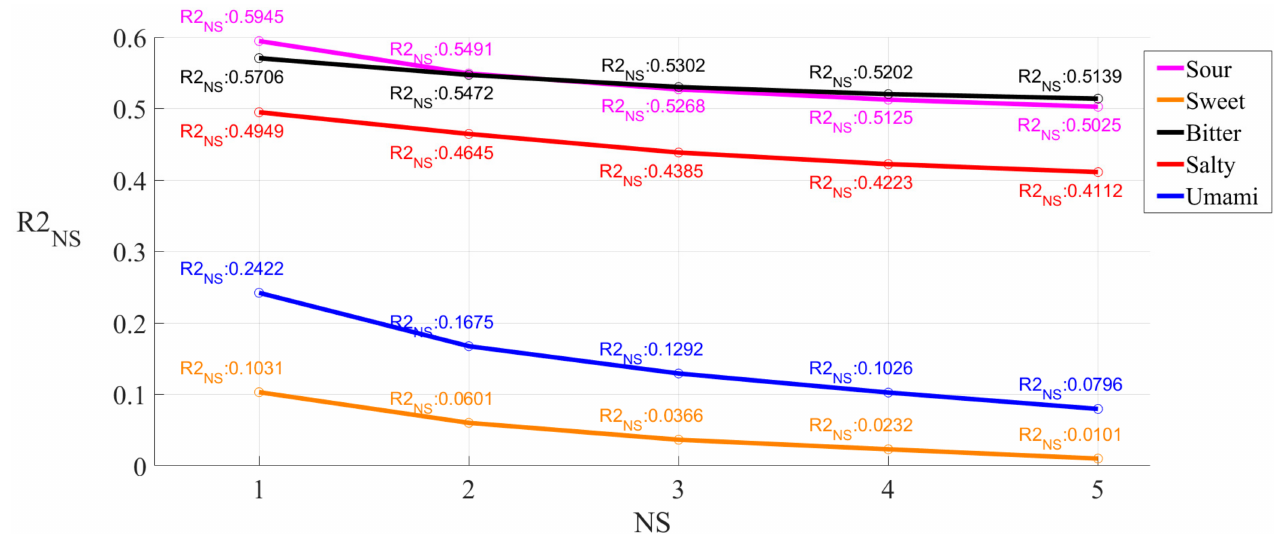
Figure 10. Relation between R 2 NS and NS. NS is the number of subjects. We listed all possible subject combinations of NS subjects for each NS (NS = 1, 2, . . . 5) and constructed a new dataset series for each combination by combining datasets series of subjects in the combination. After performing the SVM, we could get an R 2 score for each combination and each taste type. For each type and each NS, the mean value of the R 2 scores was marked as R 2 NS . The figure shows that the trend of R 2 NS changed as the NS